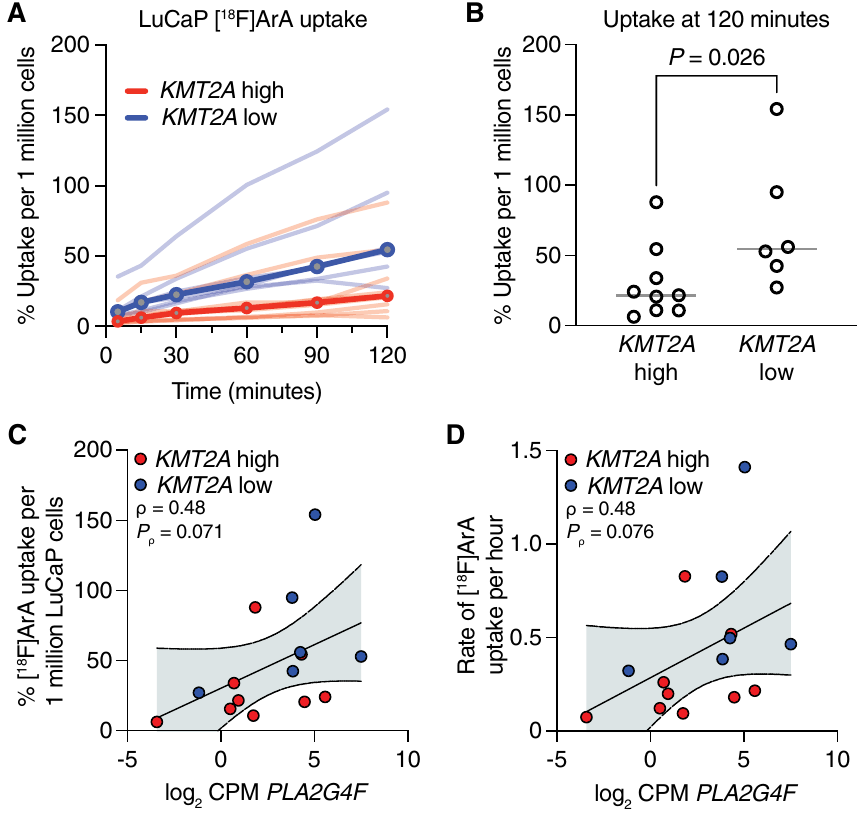
Fig. 5 Arachidonic acid (ArA) metabolism is associated with KMT2A expression. A Time course of [ 18 F]ArA uptake in LuCaP PDX organoids ( N = 15) classified as either KMT2A- high (red) or KMT2A -low (blue). Individual organoids are given by light shaded lines, with each line repre- senting the median uptake of 2–5 replicates. Dark shaded lines represent the median uptake for KMT2A- high or KMT2A -low PDX organoids. Results are expressed as median uptake per 1 million cells. B. Percent [ 18 F]ArA uptake in LuCaPs based on KMT2A expression at 120 min. Line at median. Each organoid (representing 2–5 replicate experiments) plotted as open circles ( N = 9 high, N = 6 low). P = 0.026 by Mann–Whit- ney U test. C , D Spearman correlation of the log CPM expression level of PLA2G4F with the percent [ 18 F]ArA uptake in LuCaPs at 120 min ( C ) 2 or the rate of uptake over 2 h, measured by the slope of linear regression ( D ). Cases are colored by KMT2A expression status. The error bars represent the 95% confidence bands for linear regression of each scatter